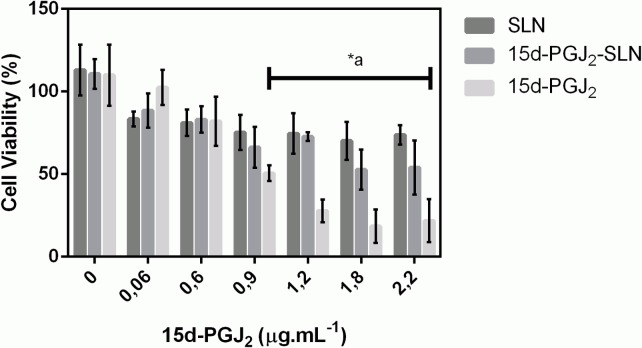
Viability of Balb-c 3T3 cells using the MTT assay after exposure to free 15d-PGJ2 and both nanosuspensions (n = 12).Data are represented as percentage of viable cells. (*a) 15d-PGJ2-SLN versus 15d-PGJ2 (ANOVA followed by Tukey test; P < 0.05).